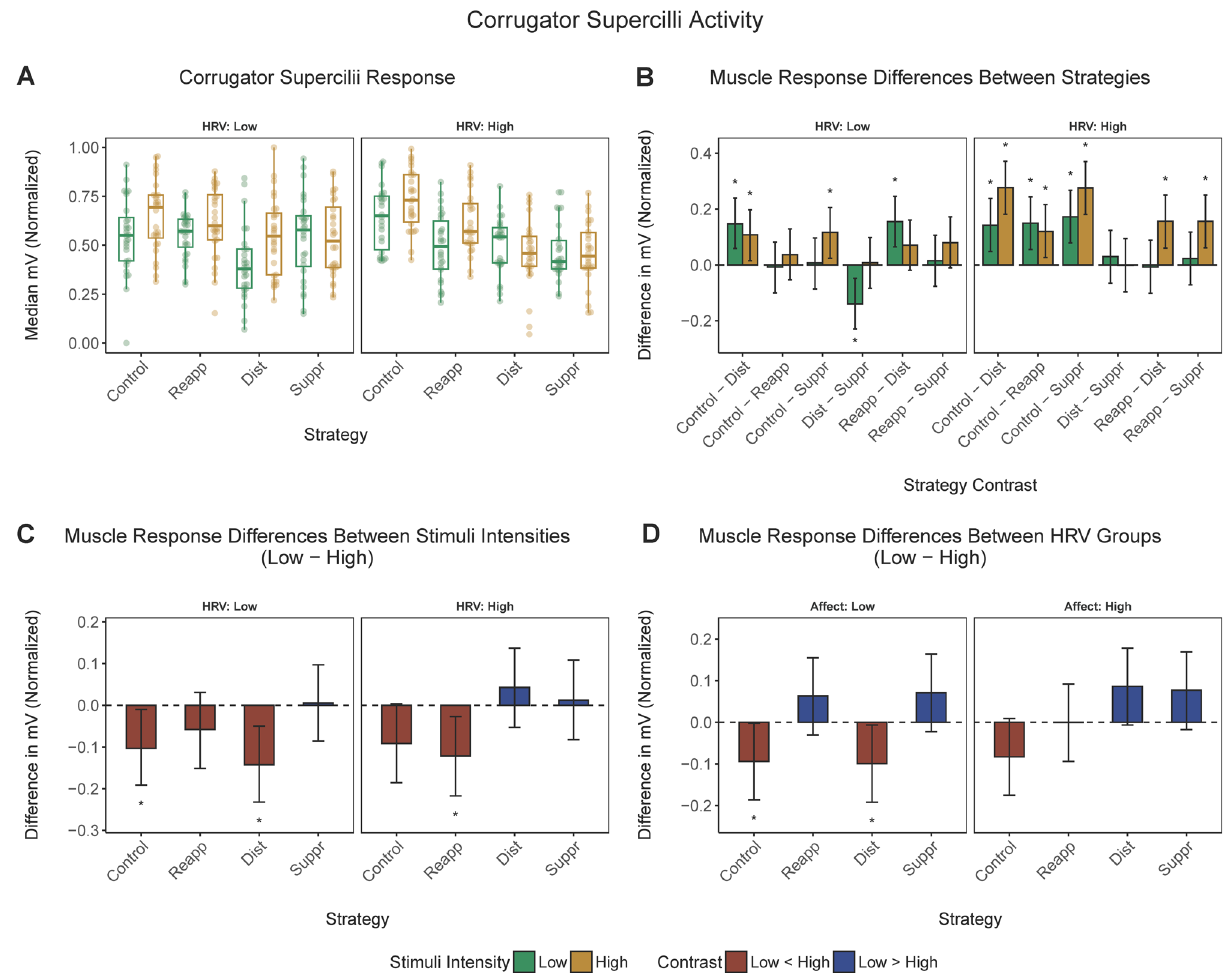
Figure 2. Corrugator supercilii activity. ( a ) Corrugator supercilii response (median) corresponding to low or high negativity stimuli in different emotion regulation conditions and low or high baseline HRV groups. ( b ) Pairwise contrasts of the corrugator supercilii response between emotional regulation conditions corresponding to low or high negativity stimuli in the low or high HRV group. ( c ) Contrasts of the corrugator supercilii response between low and high negativity stimuli across emotional regulation conditions in the low or high HRV group. ( d ) Contrasts of the corrugator supercilii response between low versus high baseline HRV groups. Corrugator supercilii activity is expressed in millivolts (mV) and has been rescaled to a range between 0 and 1. Error bars represent 95% CI of the corresponding estimate. *, significant